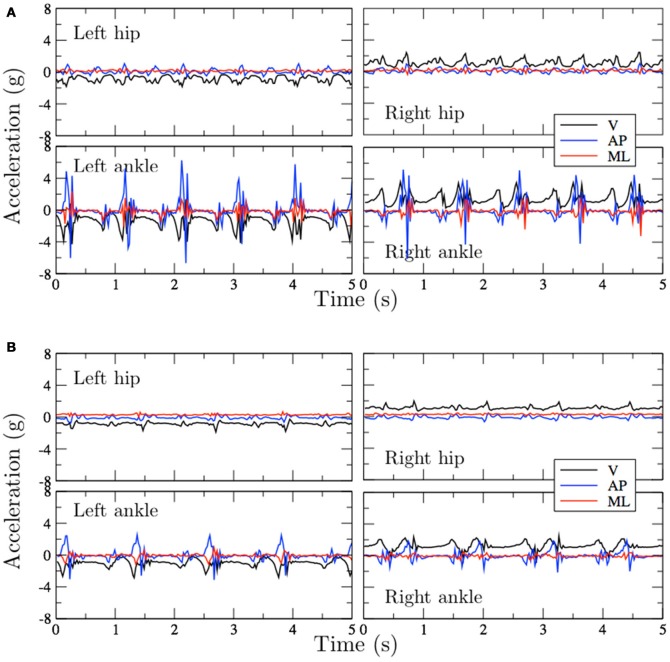
Acceleration signals obtained from experiments with two subjects walking on an indoor corridor. (A) Control (65 years). (B) PAD patient (68 years).